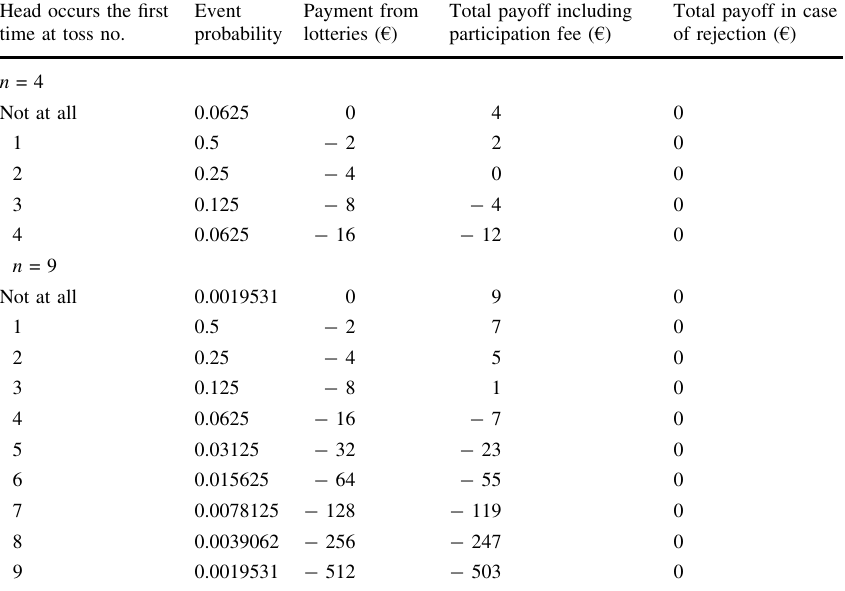
Table 1 St. Petersburg lotteries for monetary losses (for n = 4 and n = 9 games) Head occurs the first time at toss no.